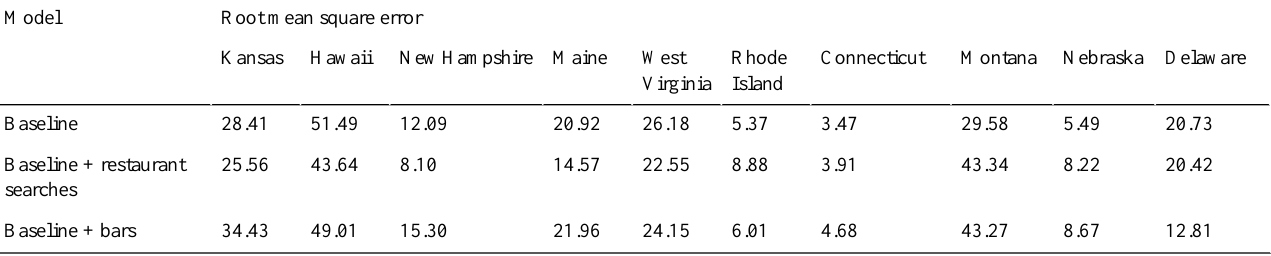
Table 6. Root mean square error scores for the time series of new COVID-19 cases (baseline), the baseline + restaurants time series, and the baseline + bars time series for the 10 US states and territories with the fewest daily new cases from April 9 to July 7, 2020.